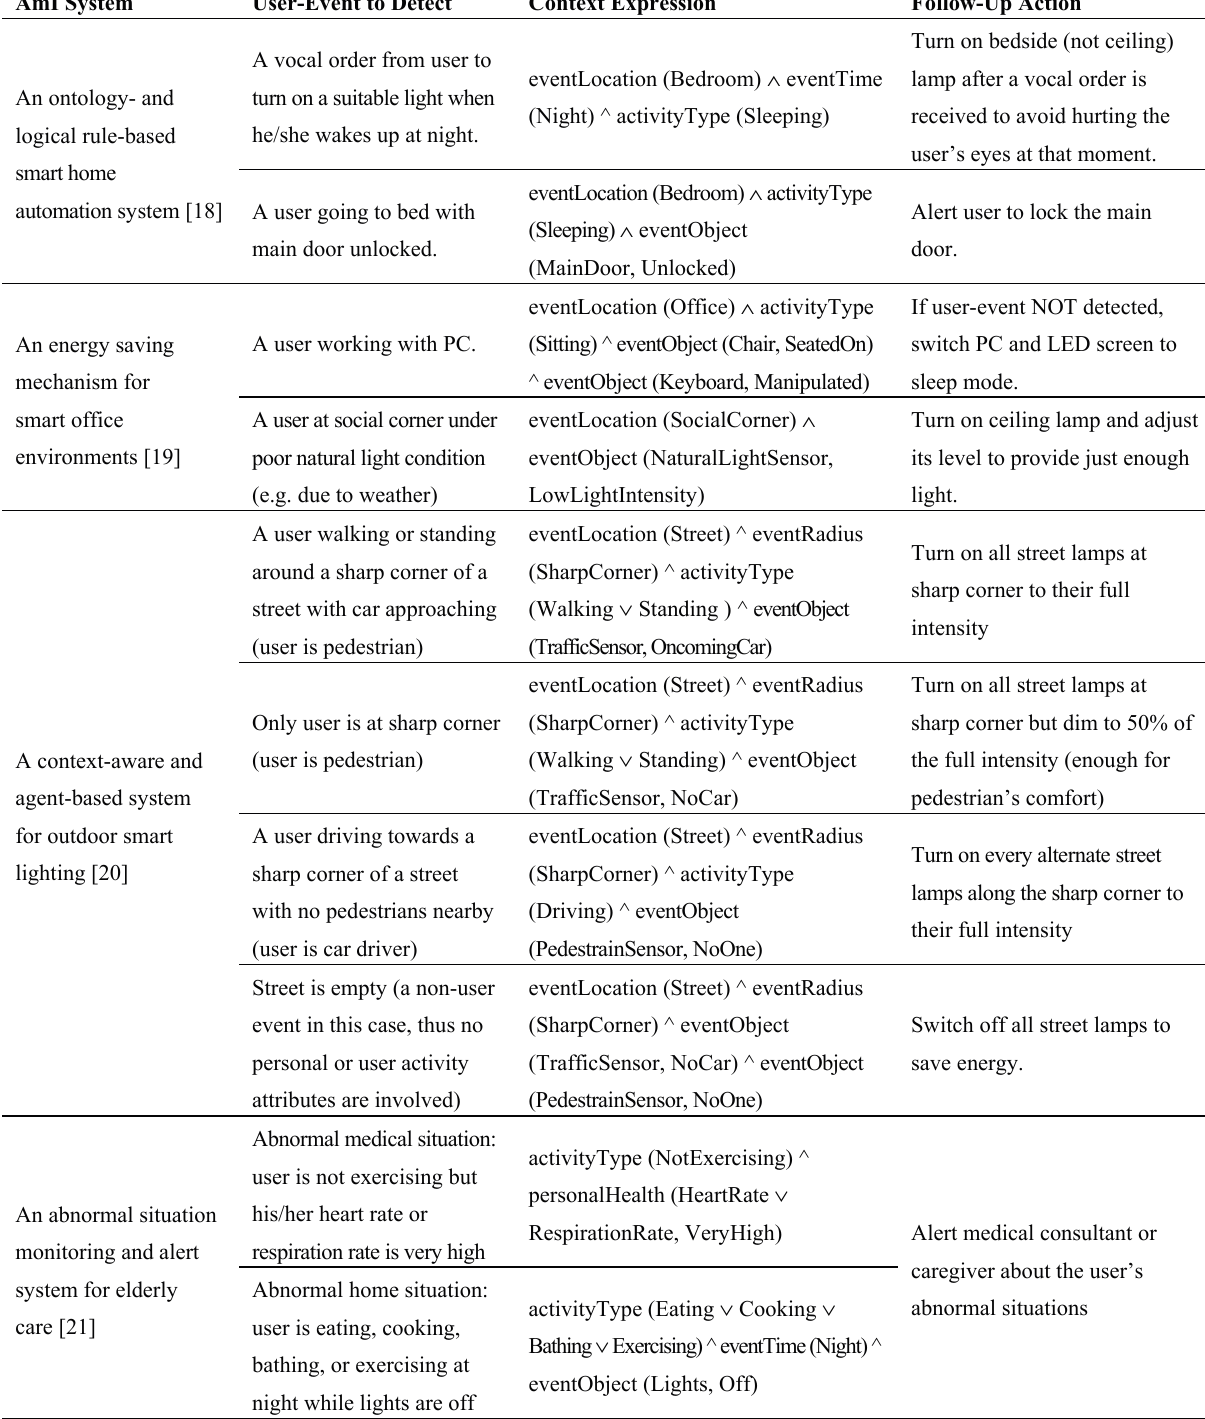
Table 1. Context representation in different AmI